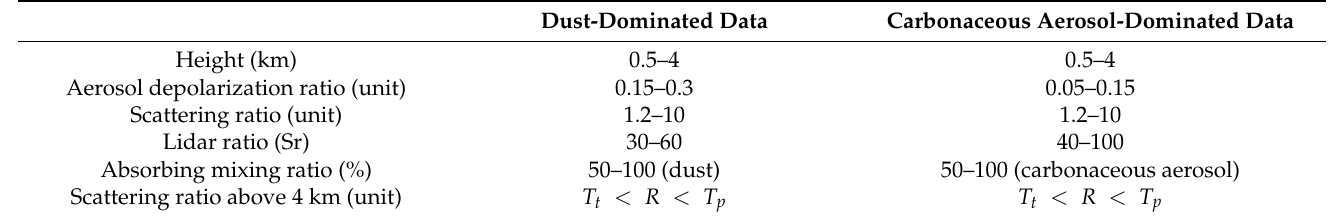
Table 2. The screening criteria for the lidar ratio data when dust or carbonaceous aerosols are the dominant type.